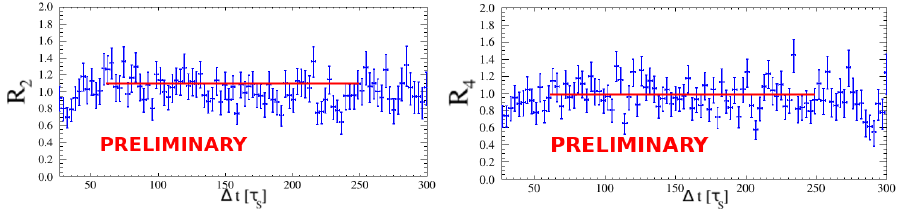
Figure 1. Preliminary distribution of the transition probability ratios R 2 (left) and R 4 (right) as a function of a proper decay time di ff erence ∆ t . Points are the KLOE data, while the red line is a fitted line to data points.